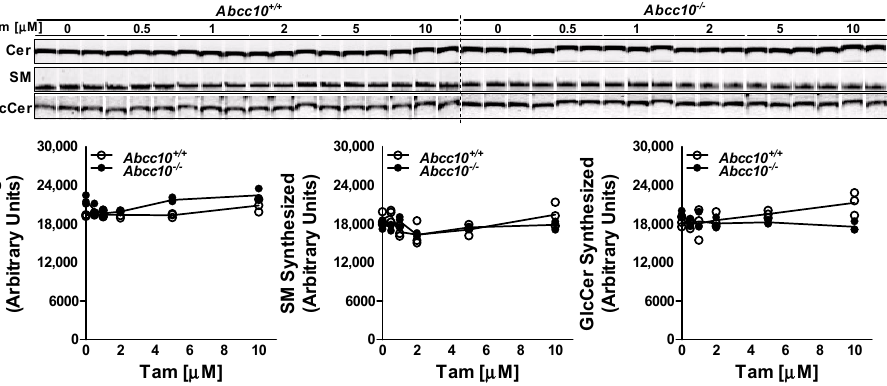
Figure 3. Tamoxifen does not affect GCS activity. Liver homogenates (500 µg protein) from Abcc10 +/+ and Abcc10 − / − mice were incubated in triplicate with C6-NBD ceramides (3.3 µg/mL), phosphatidylcholine (100 µg/mL) and UDP-glucose (500 µM) in the presence of increasing concentrations of tamoxifen (0–10 µM) at 37 °C for 1 h. Lipids were extracted from the reaction mixture and separated on TLC plate. Fluorescence in Cer, SM, and GlcCer bands was visualized with the PhosphorImager (top) and quantified using ImageJ software (bottom). Values are plotted as replicates.